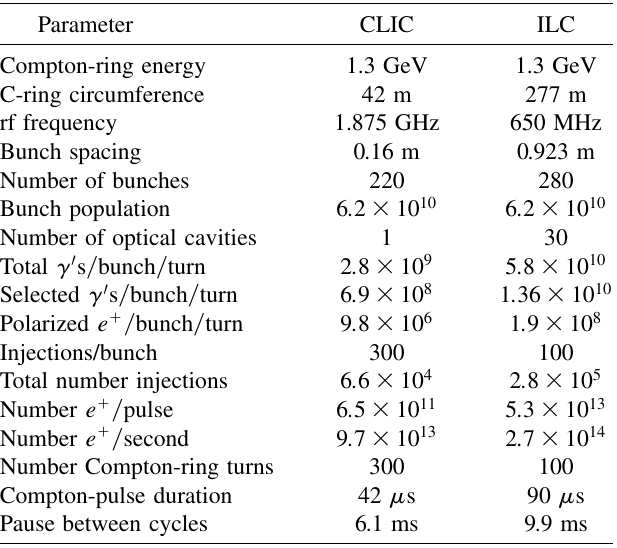
TABLE I. YAG-laser Compton-source parameters for CLIC and ILC